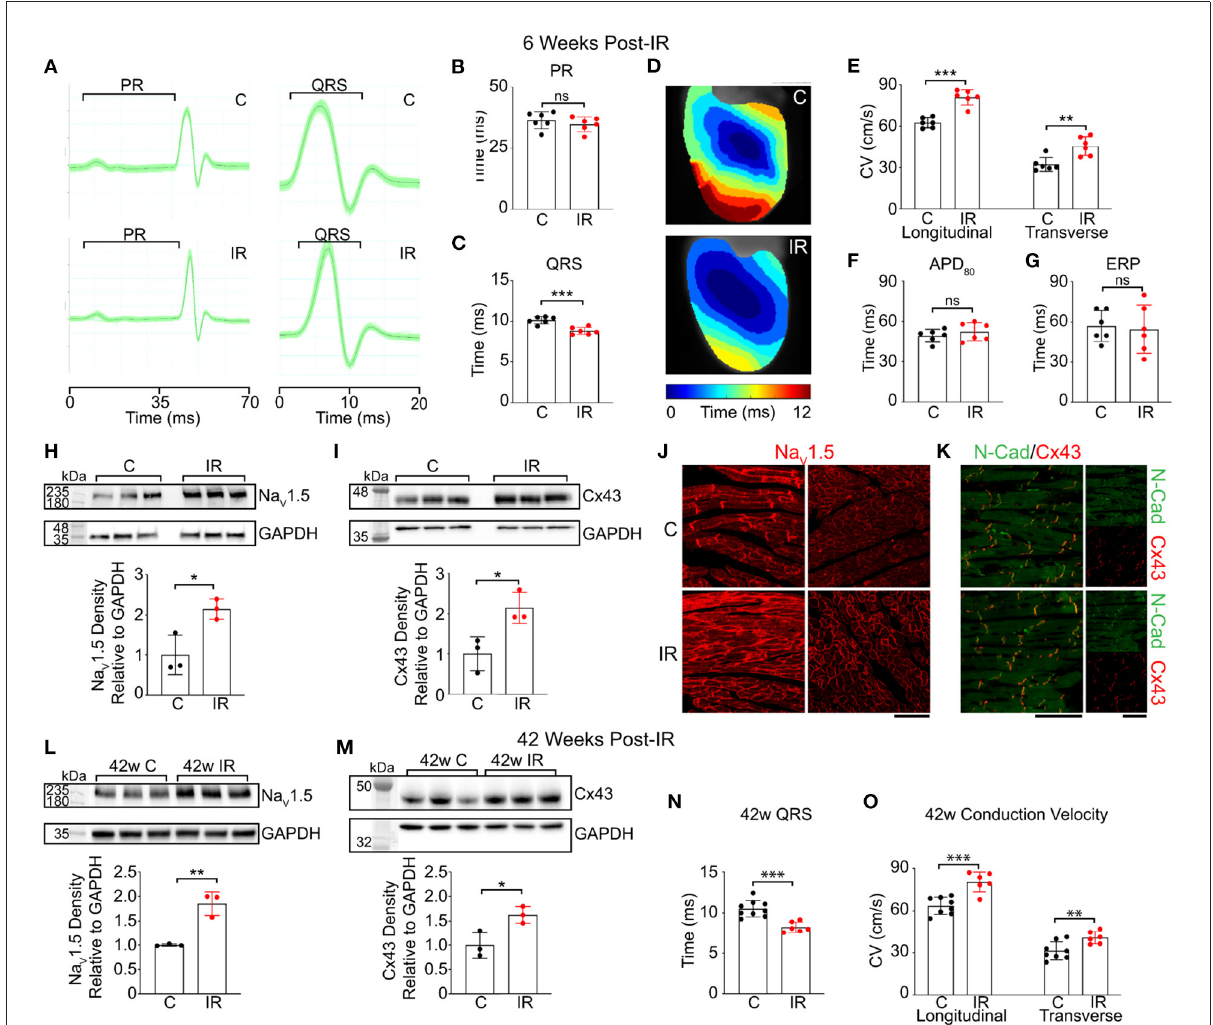
FIGURE4 Reproduced from Zhang et al. (33) under Creative Commons Attribution 4.0 International License (http://creativecommons.org/licenses/by/4. 0/) Cardiac RT persistently increases adult murine ventricular conduction. (A) Representative ECGs from control (top) and IR mice (bottom) highlighting PR and QRS intervals. (B,C) Effect of radiation on PR ( P = 0.39) and QRS (** P = 0.00043) intervals in control (black) vs. IR (red) mice ( n = 6 biologically independent animals per condition). (D) Representative ventricular activation maps from control and IR mice. Scale bars = 3mm. (E) Effect of RT on ventricular CV ( n = 6 biologically independent animals per condition; *** P = 0.00005; ** P = 0.0034). (F,G) APD80 ( P = 0.39) and ERP ( P = 0.78) in control versus IR mice ( n = 6 biologically independent animals per condition). (H,I) Western blots of NaV1.5 (* P = 0.022) and Cx43 (* P = 0.025) in control and IR ventricles ( n = 3 biologically independent samples per condition). (J) Immunostaining of control (top) and IR (bottom) myocardium for NaV1.5 and (K) co-stained for Cx43 (red) and N-Cadherin (green). Scale bars = 70 µ m. Experiment was replicated 3 times in biologically independent specimens and produced similar results. (L,M) Western blots of NaV1.5 (** P = 0.0034) and Cx43 (* P = 0.027) after 42 weeks post-IR ( n = 3 biologically independent samples per condition). (N) Effect of RT on QRS intervals in control vs. IR mice after 42 weeks (*** P = 0.00027; C, n = 9; IR, n = 6). (O) Left ventricular CVs in control ( n = 9 biologically independent animals) vs. IR (n = 6 biologically independent animals) mice at 42 weeks post-IR (*** P = 0.00042; ** P = 0.0092). All P values determined by two-way unpaired t